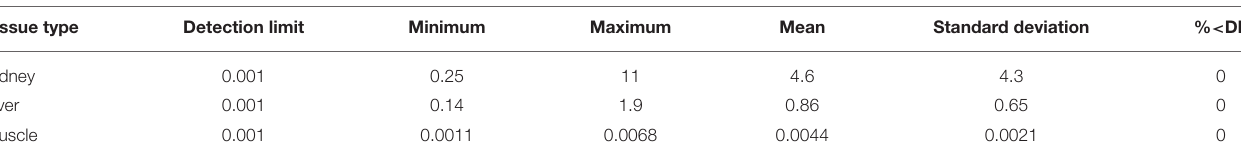
TABLE 7 | CLFN Summary Statistics ( n =